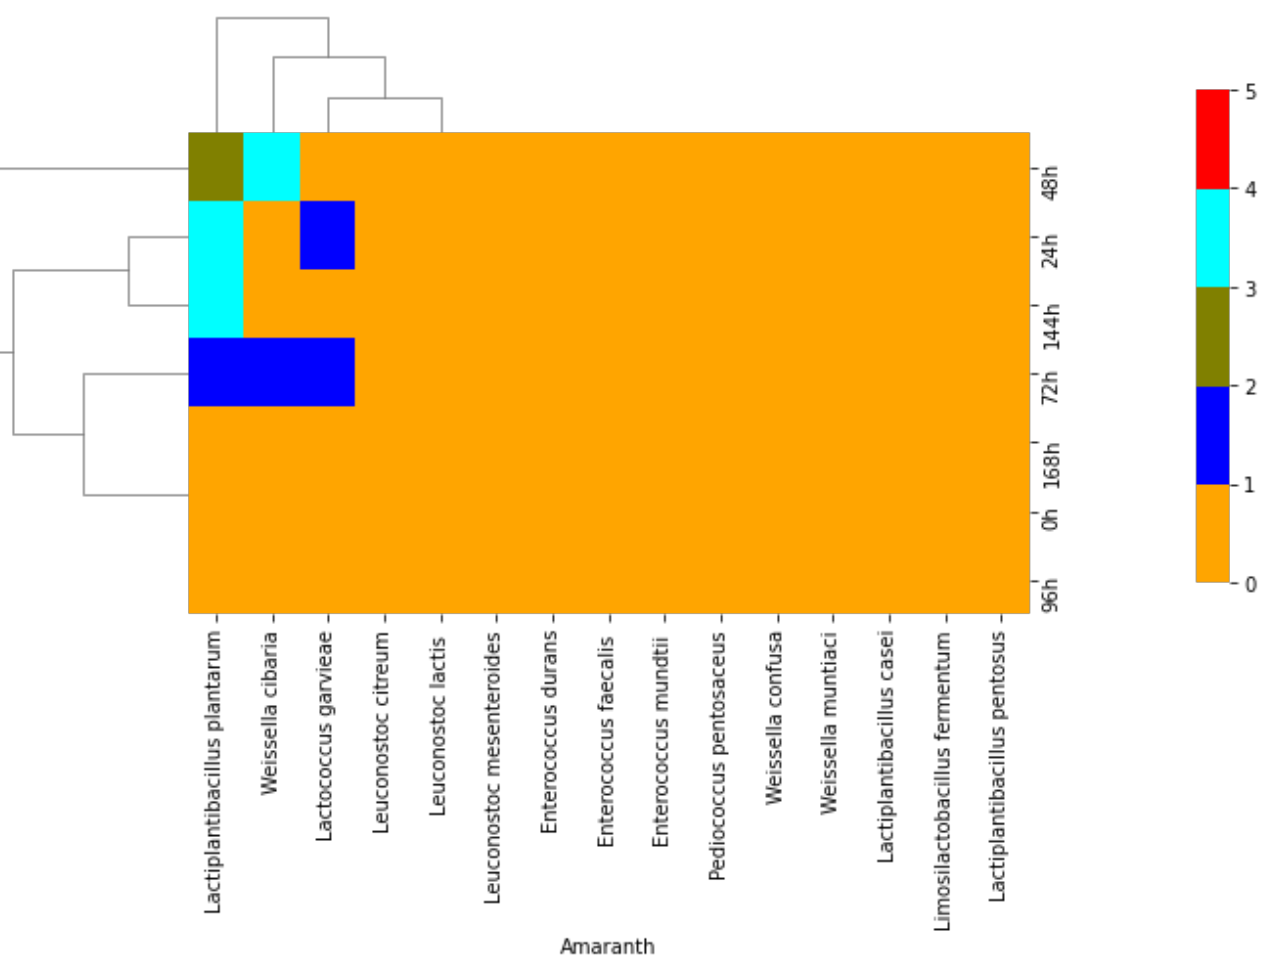
Figure 5. Hierarchical clustering of lactic acid bacteria species from fermented vegetable amaranth at different fermentation times. Legend: Hierarchical clustergram generated using several bacterial species from Amaranth at different Times. The heatmap (Euclidean matric) shows the relationship between selected bacteria species (Amaranth) and varied times. The colored scale bar indicates the significant quantified strength of the various times. The red color in the heatmap indicates the highest and orange indicates the lowest significance at p ≤ 0.05 for the assayed treatments.